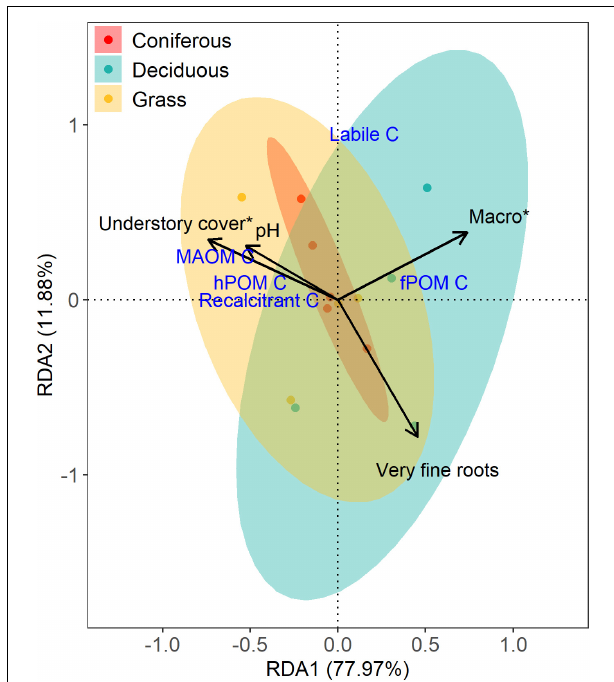
FIGURE 4 | Canonical redundancy analysis (scaling 2) demonstrating the relationships among vegetation and soil properties, and soil C pools in the studied soils. Blue text represents response variables and black text and arrows represent the environmental variables that explained variance in the response variables among study sites. Significant explanatory variables ( p ≤ 0.05) are indicated by a